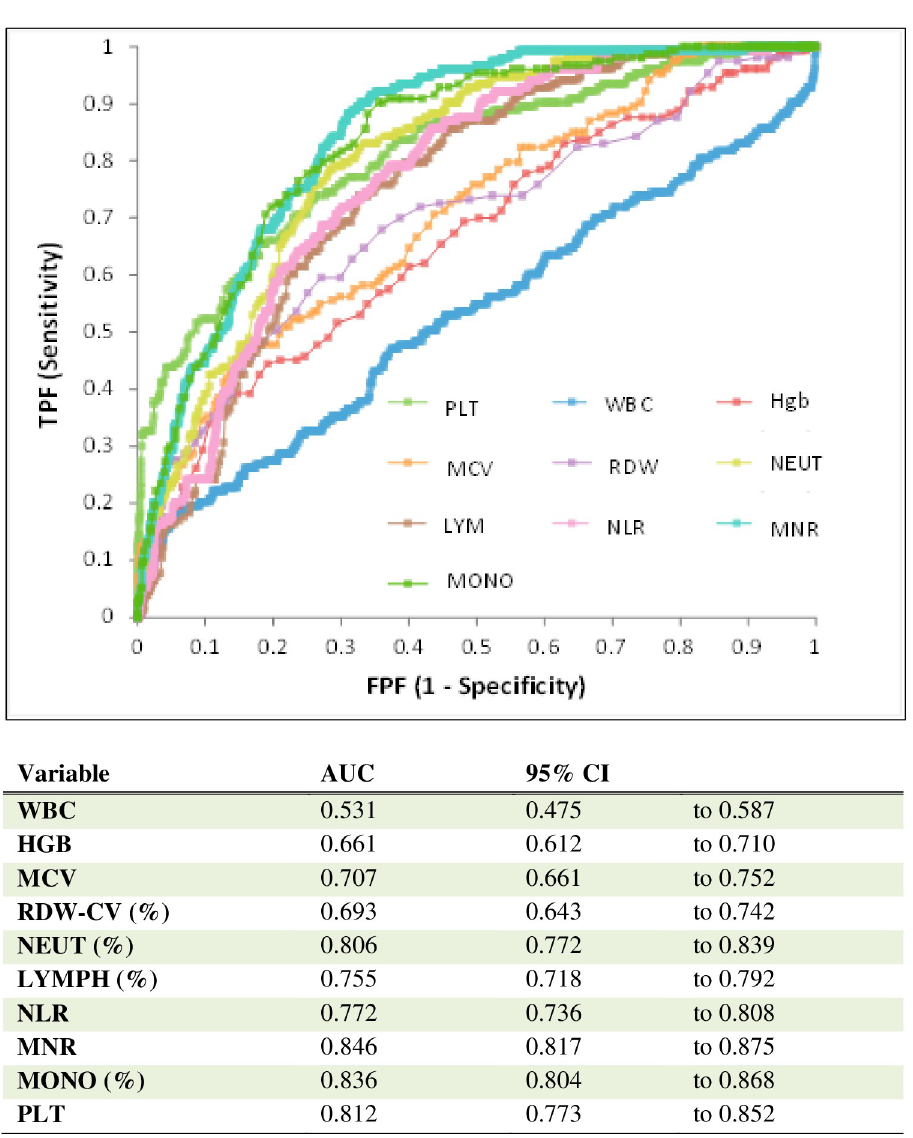
Fig 3. ROC analysis using combined parameters for the assessment of mortality risk in COVID-19